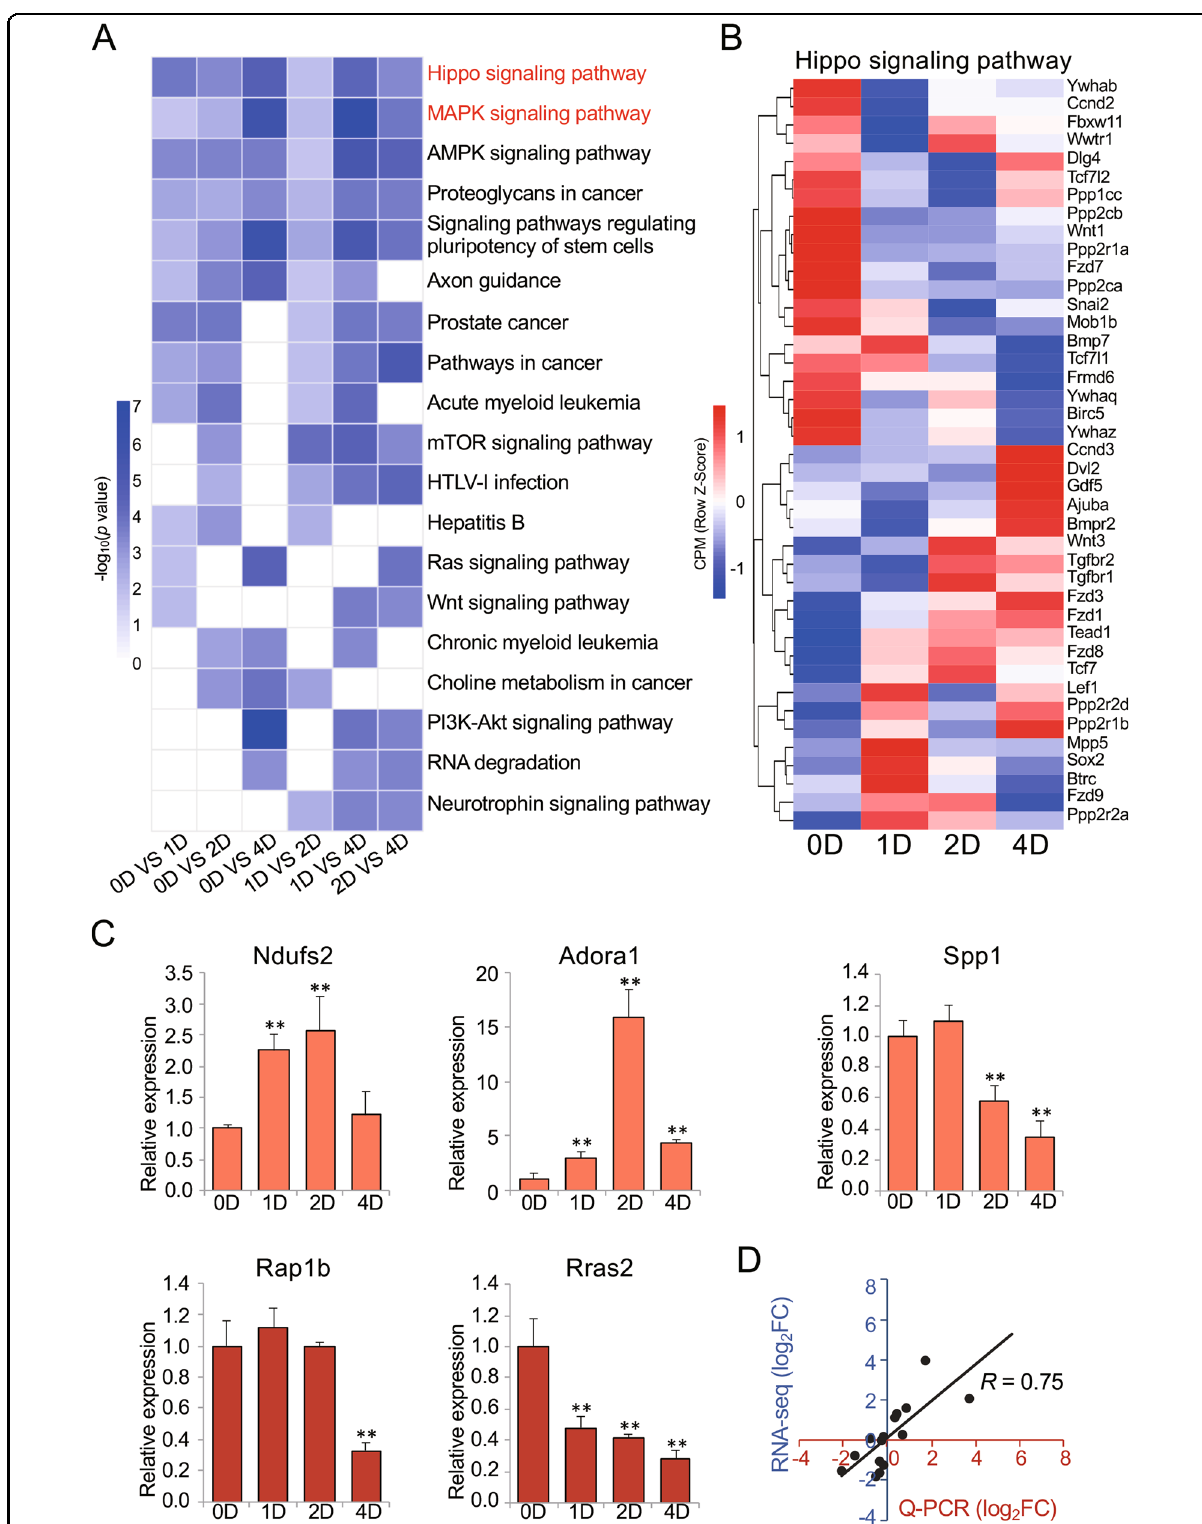
Fig. 3 KEGG pathway annotation and RNA-seq dataset analysis. a KEGG pathways most signi fi cantly enriched in the top 20 differentially expressed miRNA targets ranked by the enrichment score ( − log 10 ( p value)). b Heat map and clustering patterns of miRNA targets in the Hippo signaling pathway during C2C12 myoblast differentiation as determined by rRNA-depleted RNA-seq data. c Expression of genes as quanti fi ed by Q- PCR. The expression fold change is relative to day 0 in GM culture. d Scatter plot showing the two general methodologies. The x -axis shows the values obtained by Q-PCR, and the y -axis shows the values obtained by RNA-seq. * p < 0.05; ** p < 0.01. Of fi cial journal of the Cell Death Differentiation